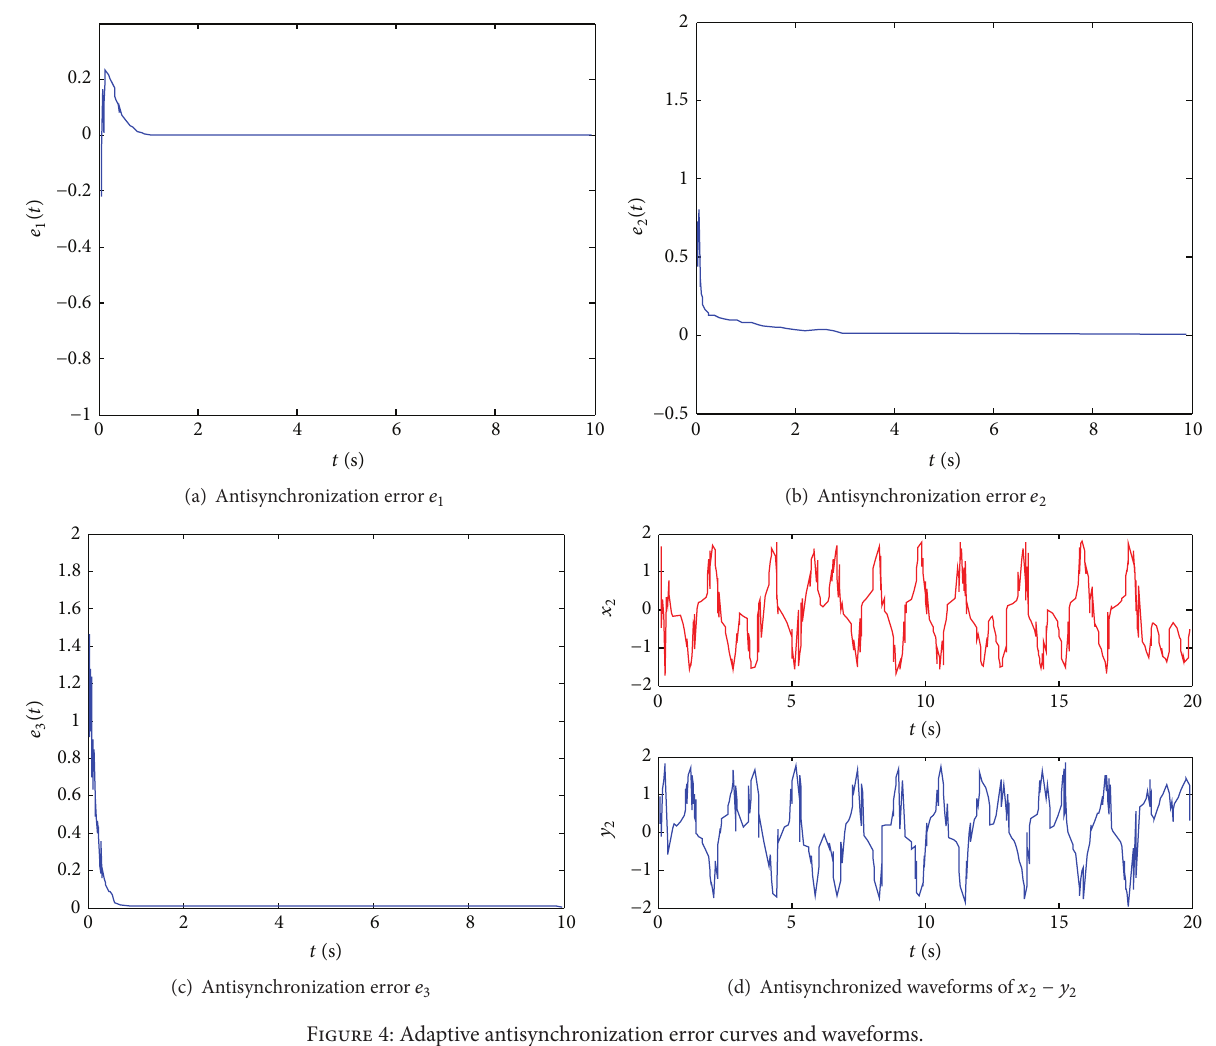
Figure 4: Adaptive antisynchronization error curves and